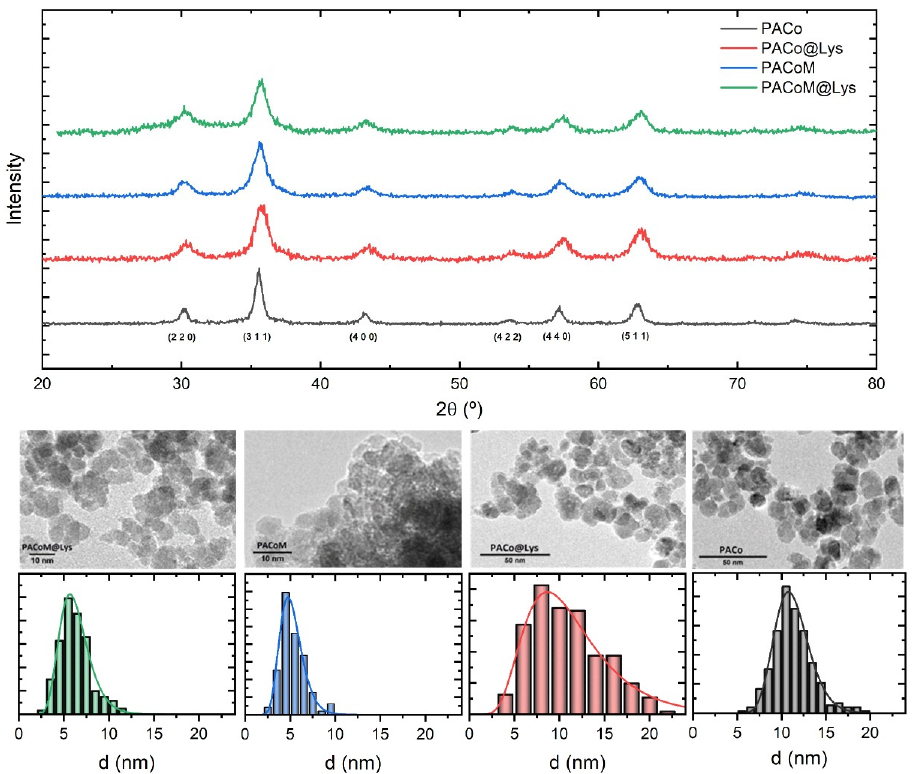
Figure 2. Upper panel: XRD spectra of PACo, PACo–Lys, PACoM, and PACoM–Lys samples. Lower panel: TEM image of samples PACo, PACo–Lys, PACoM, and PACoM with size histograms obtained from TEM images and log-normal fit . Table 1. Parameters of samples characterization: mean characteristic sizes ( d XR , d 0 ), cell parameter (< a >) polydispersity index ( s ), BET specific surface area ( S BET ), and magnetic properties ( M S , H C, χ 0 ).